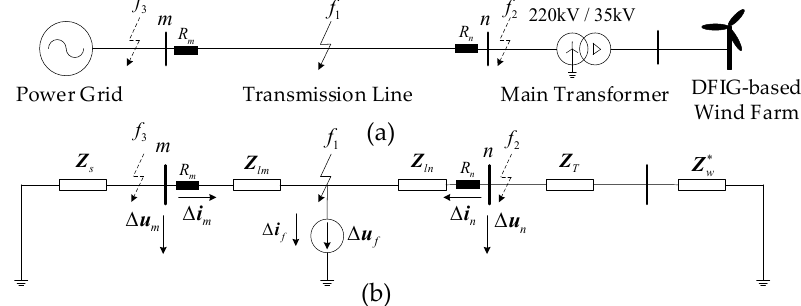
Figure 10. Model of the transmission line connected to a DFIG-based wind farm and its fault component network : ( a ) transmission line model; and ( b ) fault component network.